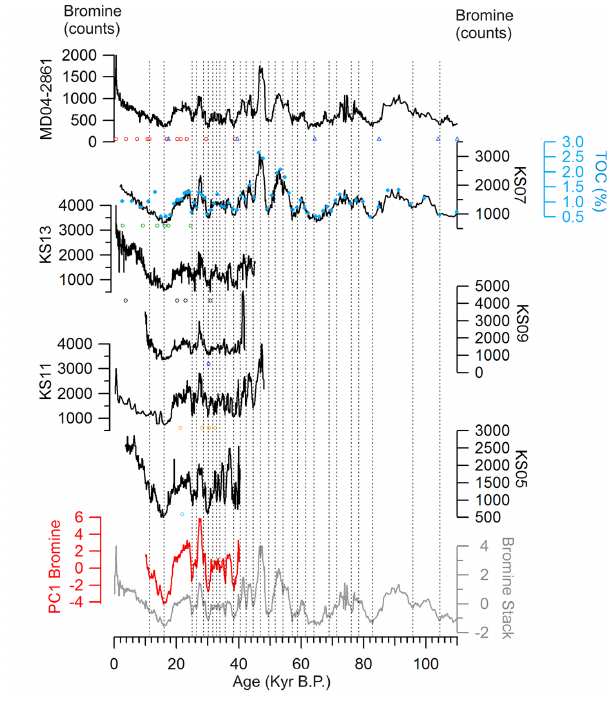
Fig. 3. Bromine signals and accompanying bromine stack and PC1- bromine for the whole Arabian Sea. All the bromine XRF-count sig- nals obtained for the six studied cores are visible for the last 110kyr. For cores MD04-2861, KS13, KS09, KS11, KS05 and KS07, age control points are indicated by coloured circles ( 14 C dates) and blue triangles (GEs). Blue dots for core KS07 refer to total organic car- bon (TOC) values. Black dashed lines indicate common events of low bromine values in each